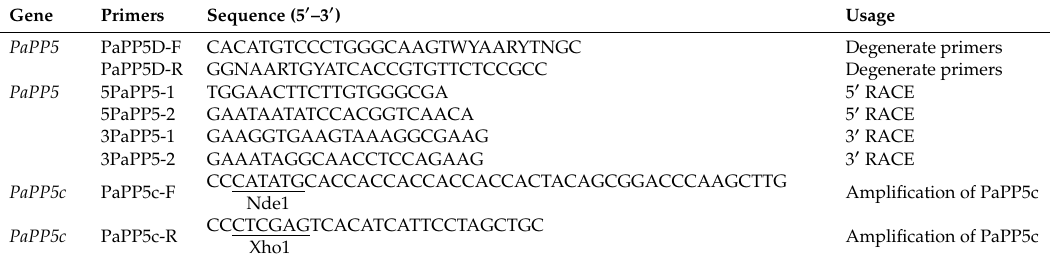
Table 2. Primers used in this